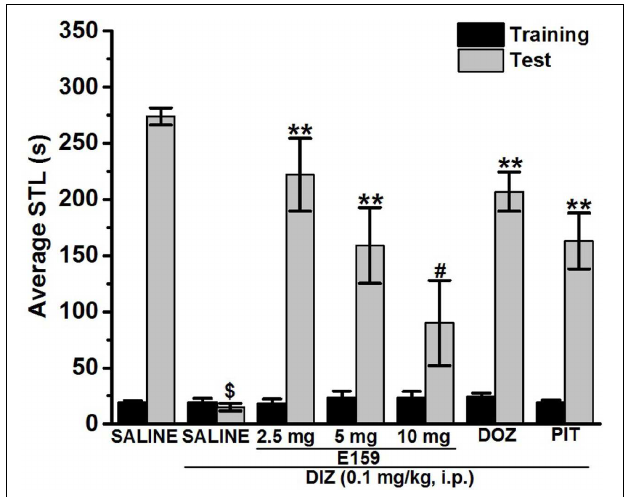
FIGURE 3 | Effect of vehicle, E159, PYR, and ZOL on DIZ-induced deficit in an inhibitory avoidance conditioned response in rats. Gray columns represent the mean STLs measured during the retention test (test latencies) and black columns the mean STLs measured during the training trial before the delivery of the foot-shock (pre-shock latencies). Rats were injected with E159 (2.5 mg/kg, i.p.), PYR (10 mg/kg, i.p.) or ZOL (10 mg/kg, i.p.) 30–45 min before the test session. $ P < 0.001 for mean STLs vs. the value of the (Saline)-treated group. ∗∗ P < 0.001 for mean STLs vs. the value of the (DIZ)-treated group. ∗ P < 0.001 for mean STLs vs. the value of the (DIZ + E159)-treated group. & P < 0.05 vs. the value of the (DIZ)-treated group. Data are expressed as mean ± SEM ( n =